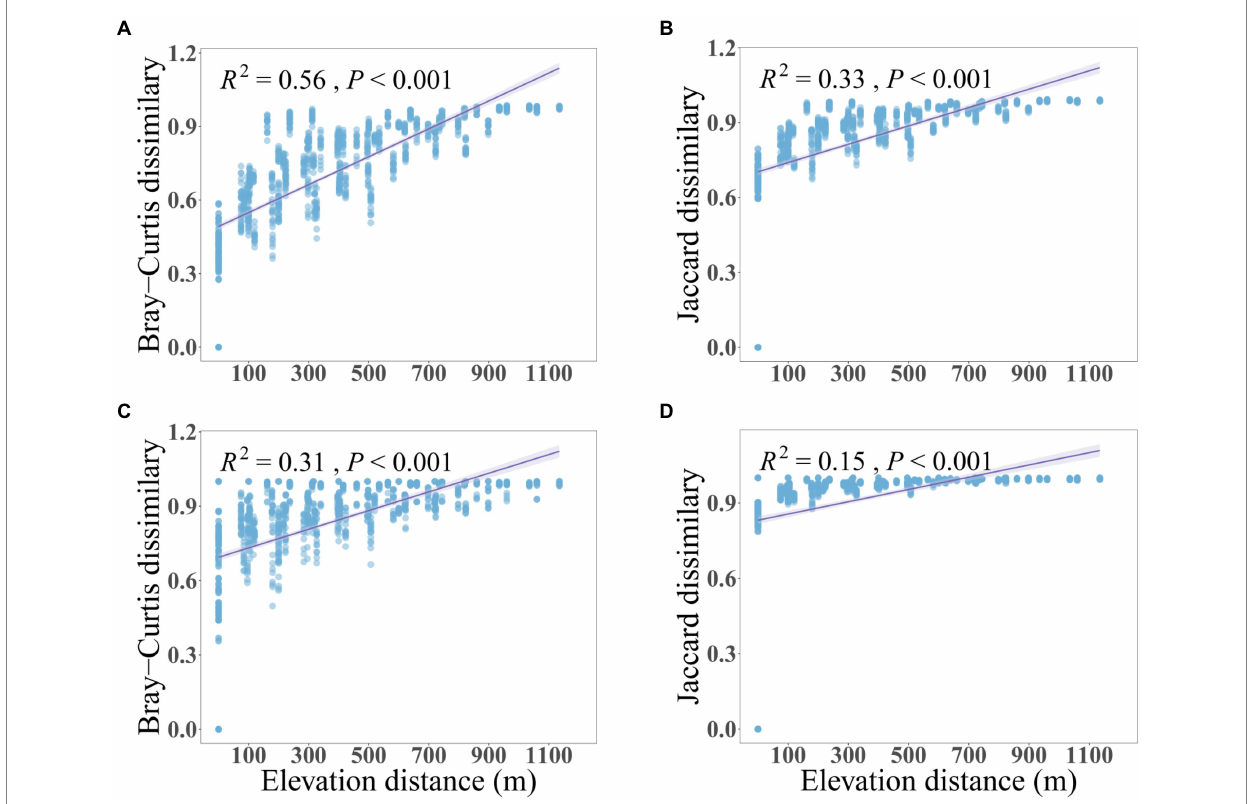
FIGURE 2 The relationships between compositional dissimilarity of soil bacteria (A,B) and fungi (C,D) with elevation differences. The solid lines represent the fitted linear